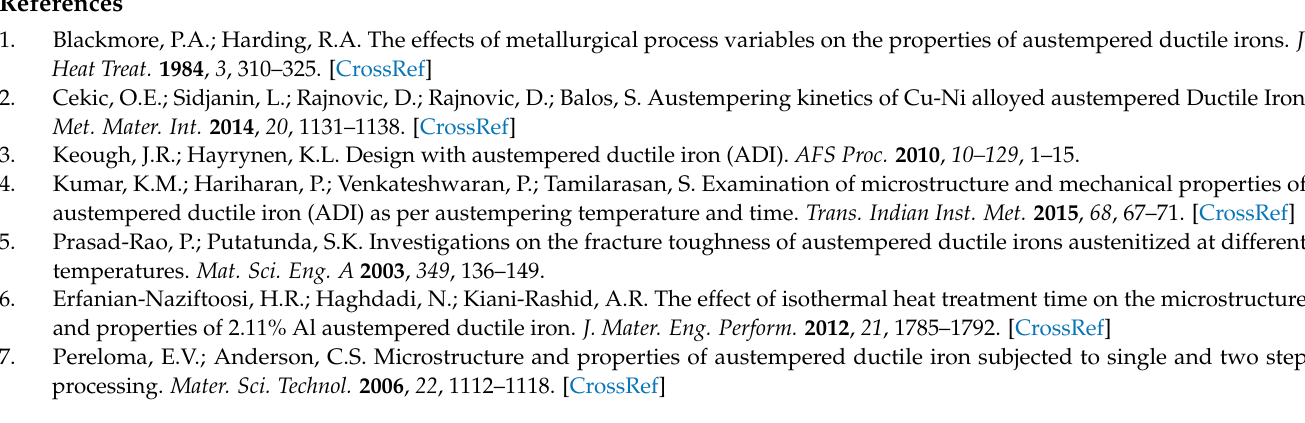
Figure A2. Microstructural evolution for the ADI ‐ 0.3V ‐ 305 sample at the austempering times of 30, 60, 90, and 120 min.